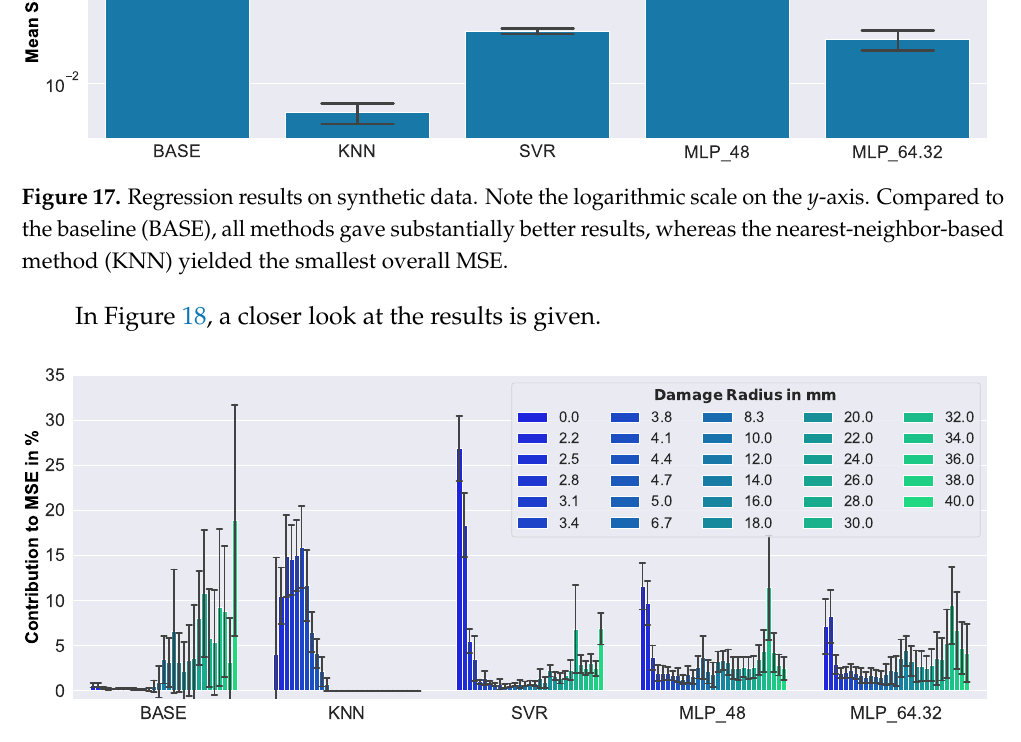
Figure 18. Relative contribution to the overall MSE, for each defect size, of synthetic